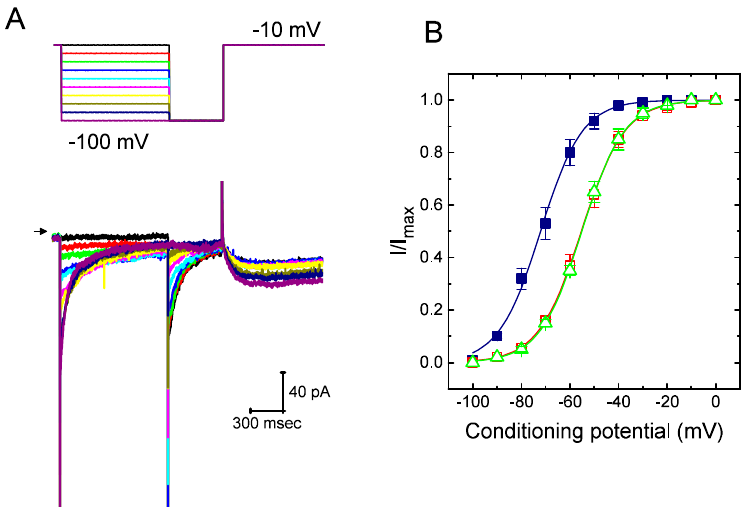
Figure 3. Effect of UCL-2077 on steady-state activation of I K(erg) in GH 3 cells. ( A ) Superimposed I K(erg) traces obtained during cell exposure to UCL-2077 (10 μ M). We bathed cells in high-K + , Ca 2+ -free solution and, during the recordings, filled the recording electrode by using K + -containing solution. The 1-sec conditioning hyperpolarizing pulses to various voltage steps ranging from − 100 to 0 mV in 10-mV increments were applied to the examined cell from a holding potential of − 10 mV, and following each conditioning pulse, a 500-msec test pulse to − 100 mV was thereafter delivered to elicit I K(erg) . The upper part is the voltage protocol used and arrowhead indicates the zero current level. ( B ) Steady-state activation of I K(erg) in the absence ( ■ ) and presence of 10 μ M UCL-2077 ( □ ) or 10 μ M azimilide ( △ ) (mean ± SEM; n = 9 for each point). The smooth lines were approximately fitted to Equation (6).